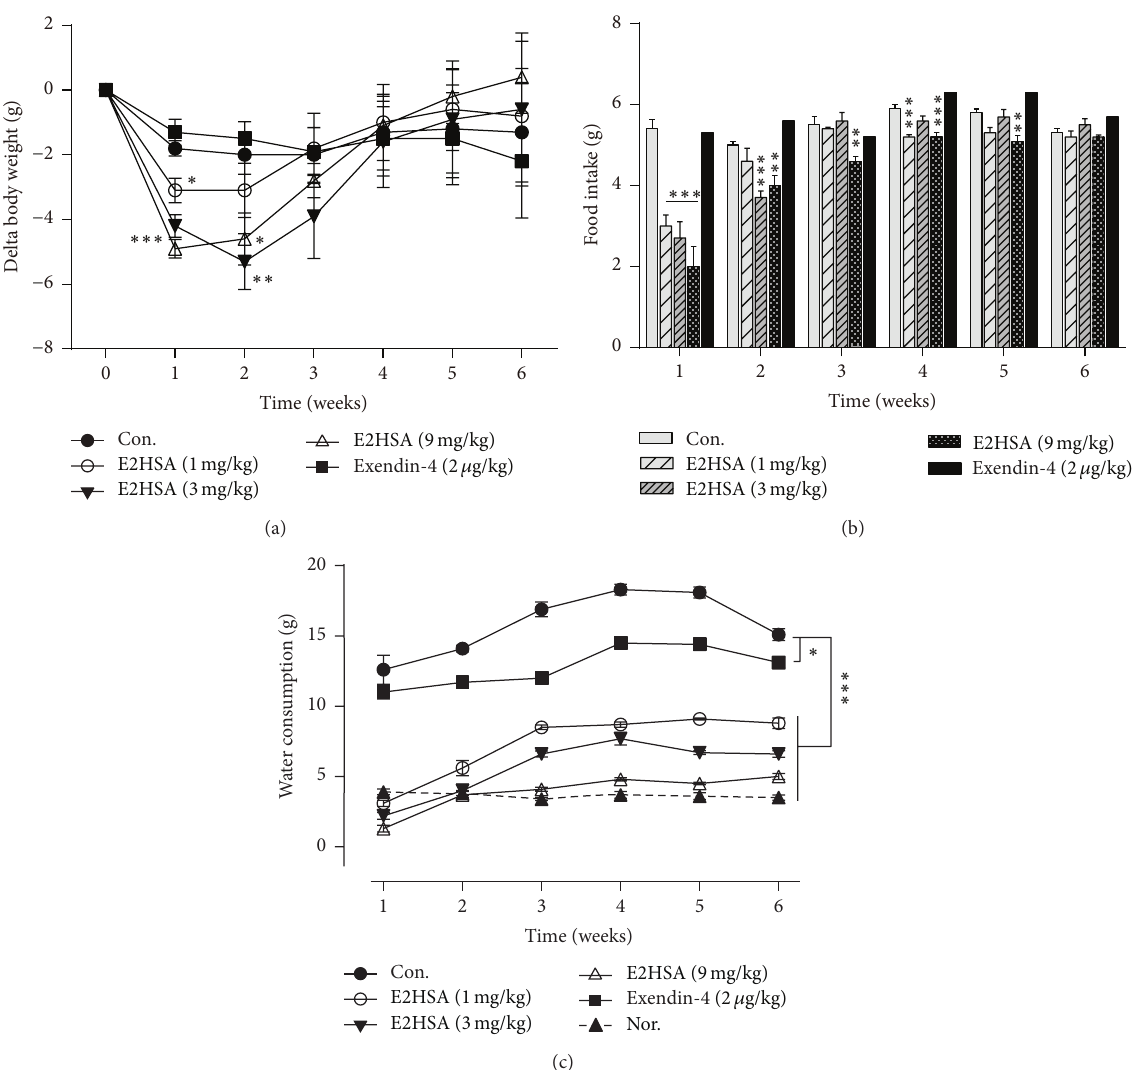
Figure 6: Chronic treatment with E2HSA decreased average body weight, inhibited average food, and water intake in spontaneous type 2 diabetes db/db mice. (a) Delta body weight change per mouse per week. (b) Average food intake per mouse per week. (c) Average water consumption per mouse per week. Con., db/db mice administered normal saline. Data are expressed as mean ± S.E.M ( 𝑛 = 10 - 11 ). ∗ 𝑃 < 0.05 , ∗∗ 𝑃 < 0.01 , and ∗∗∗ 𝑃 < 0.001 versus